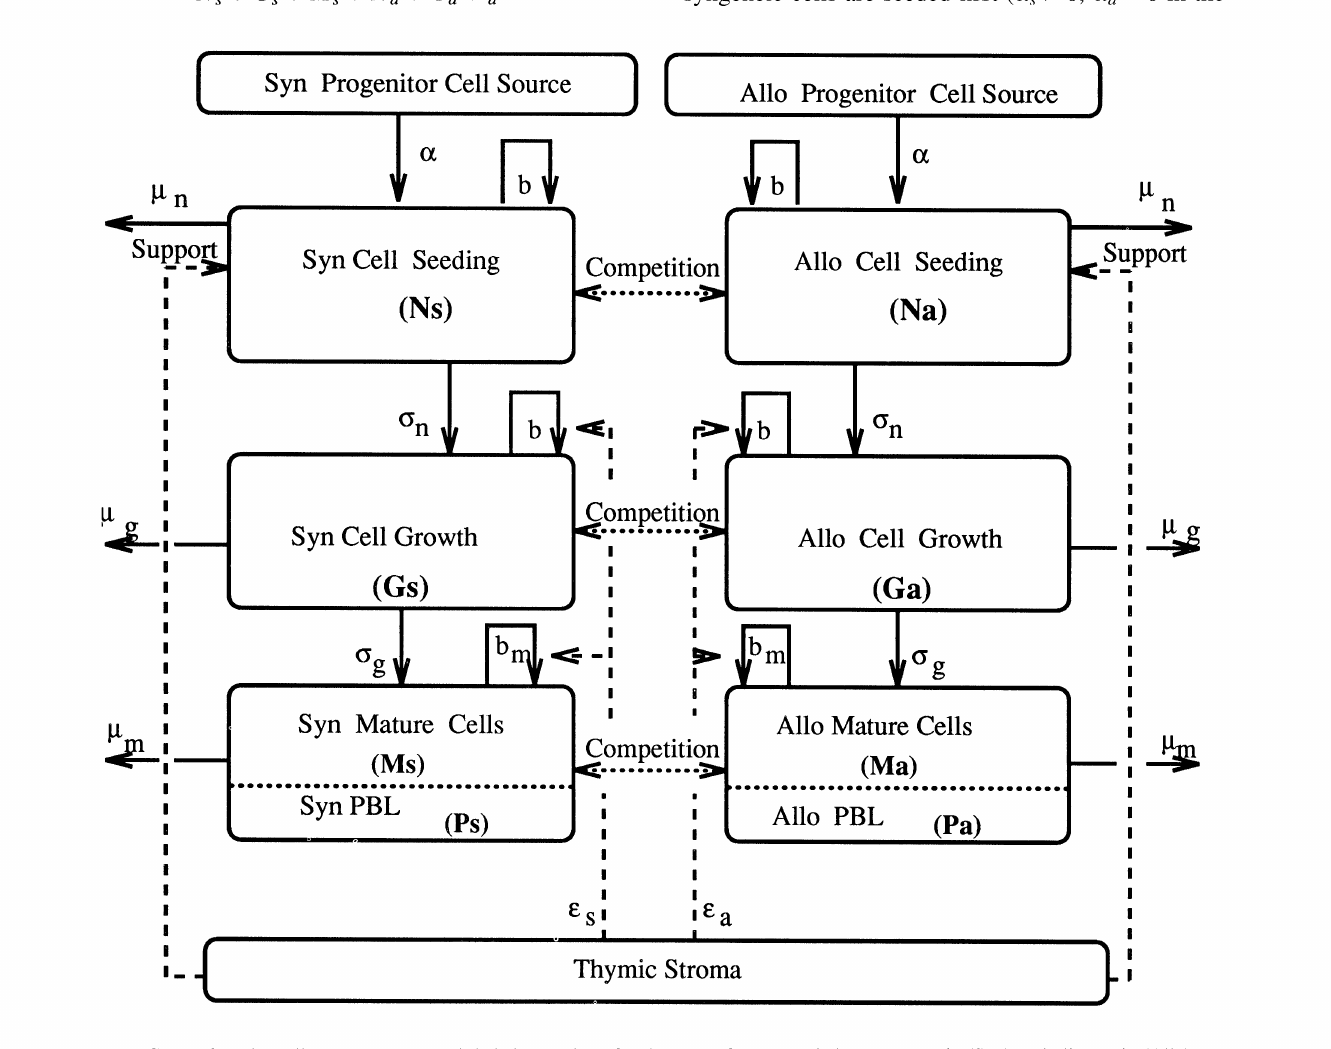
FIGURE 2 The cell compartments and their interactions for the case of two populations, syngeneic (Syn) and allogeneic